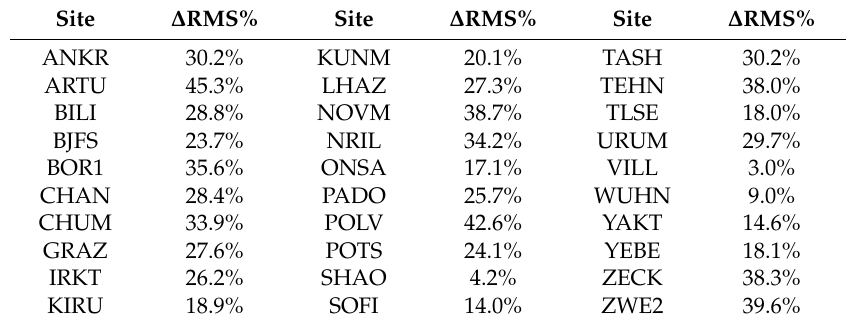
Table 3. The RMS reduction ratio in percent when correcting GPS heights with AOH